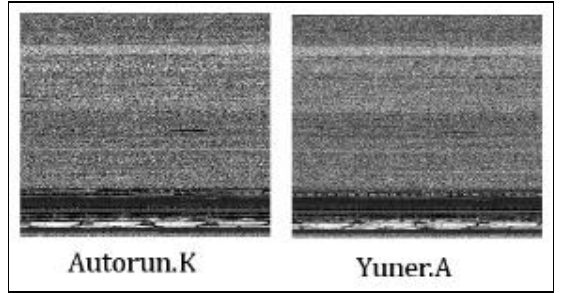
Figure 11. Autorun.K and Yuner.A samples